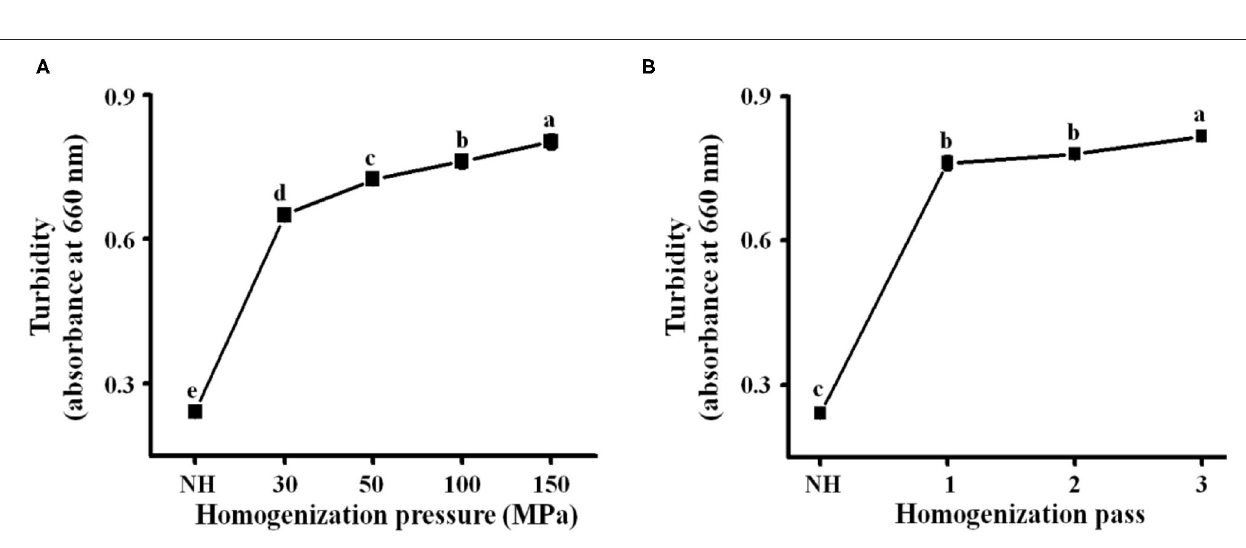
FIGURE 2 | NFC orange juice was treated with different homogenization pressures (30, 50, 100, and 150 MPa) and numbers of homogenization passes (1, 2, and 3) to study the effect of HPH on the turbidity of NFC orange juice. (A) Homogenization pressure; (B) Homogenization